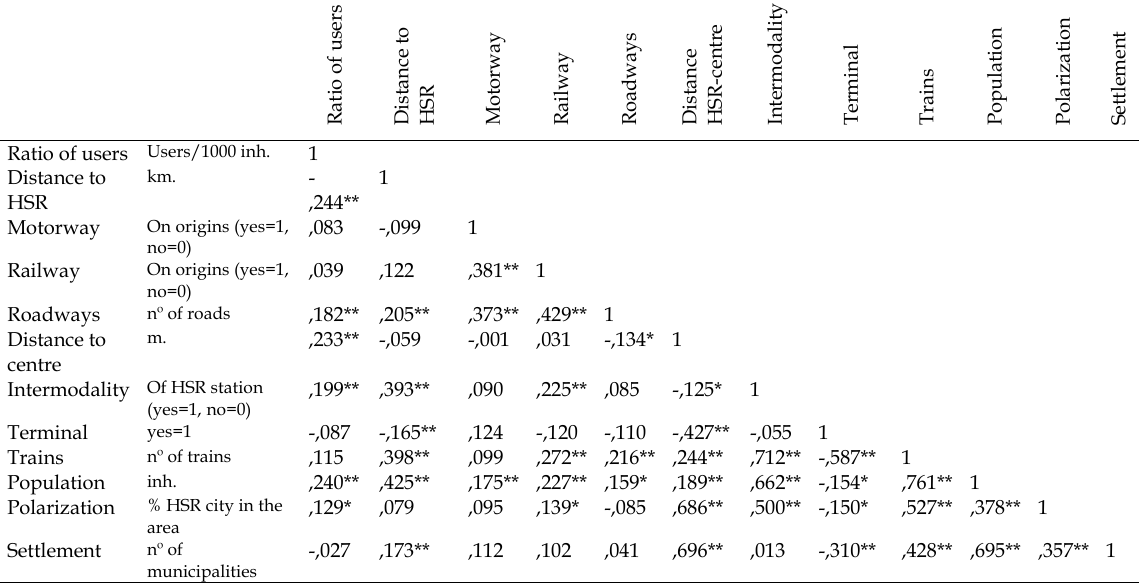
Table 2. Matrix of bivariate correlations among variables in the catchment area